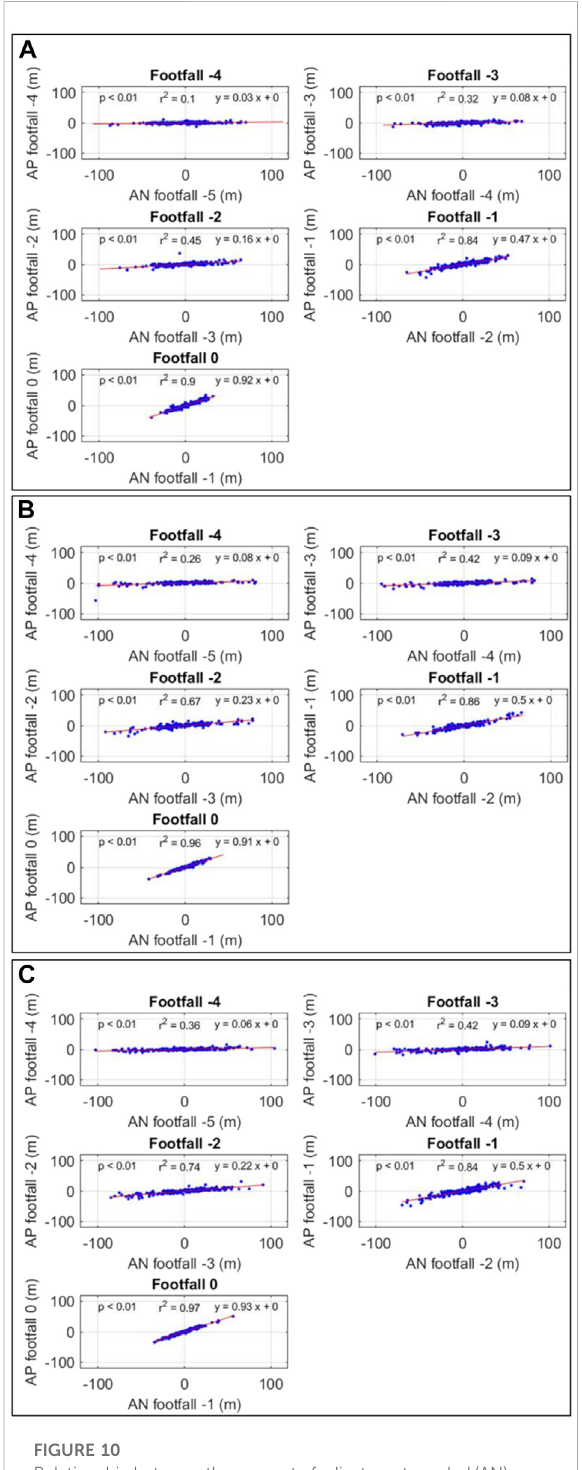
FIGURE 10 Relationshipbetweentheamountofadjustmentneeded(AN) atacertainfootfallandtheamountofadjustmentproduced(AP)in the following footfall. (A) real-world condition (B) corresponding virtual reality condition (C) outdoor virtual reality condition.